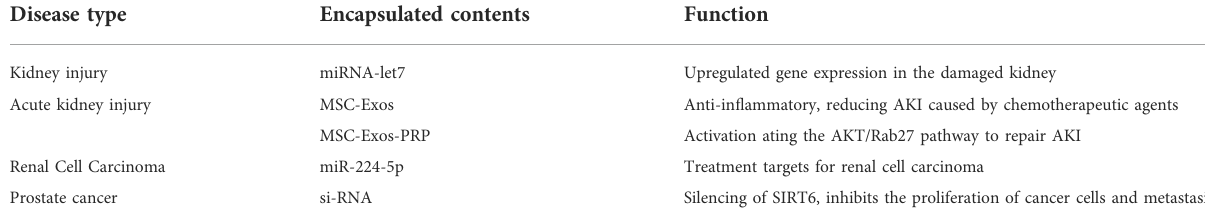
TABLE 4 Engineered exosomes in the genitourinary